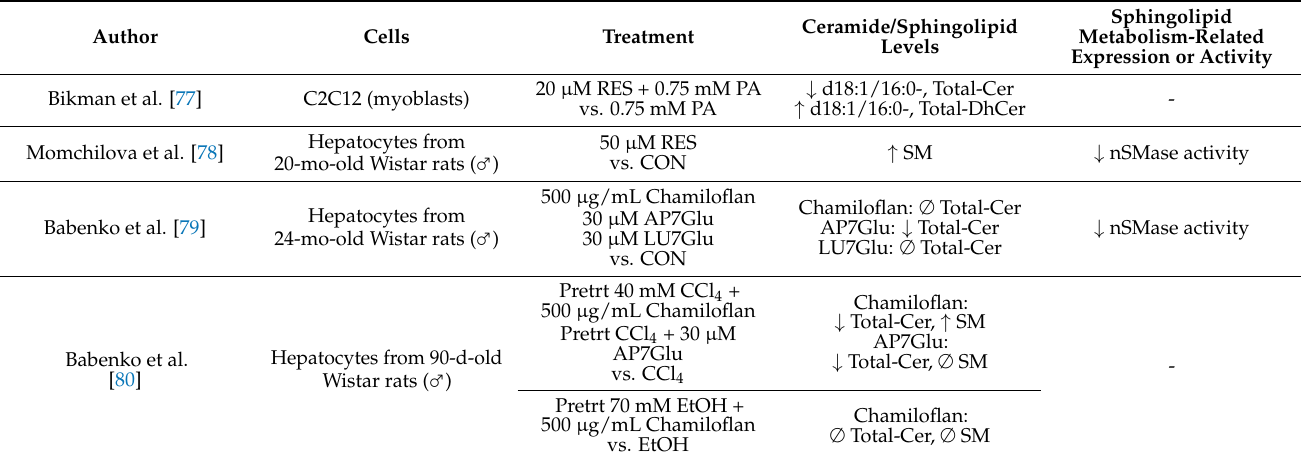
Table 1. Summary of in vitro studies examining the impact of phytochemical treatment on sphin- golipid levels and related